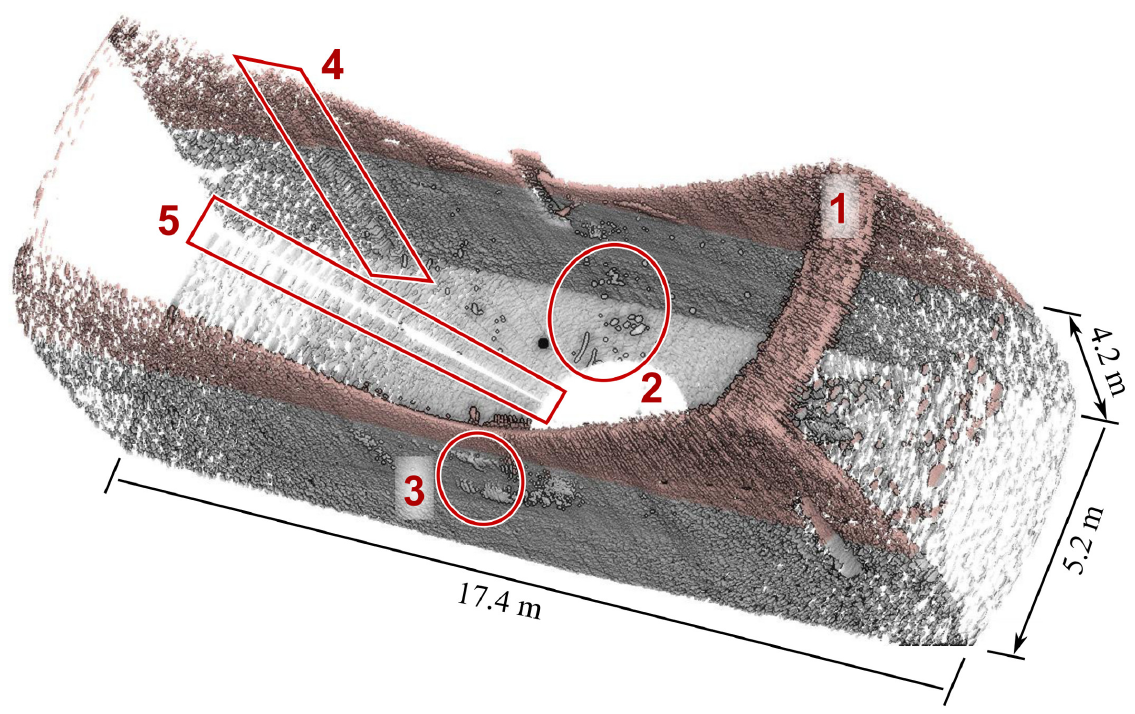
Figure 6. Rendering of a raw sonar output (from a single scanning position). 1: artifacts due to surface reflections (coloured in salmon). 2: acoustic anomalies in the water column acquisition. 3: acoustic phenomena due to signal backscattering. 4: acquisition anomaly probably due to a temporary blocking of the horizontal rotation system. 5: acquisition lack.